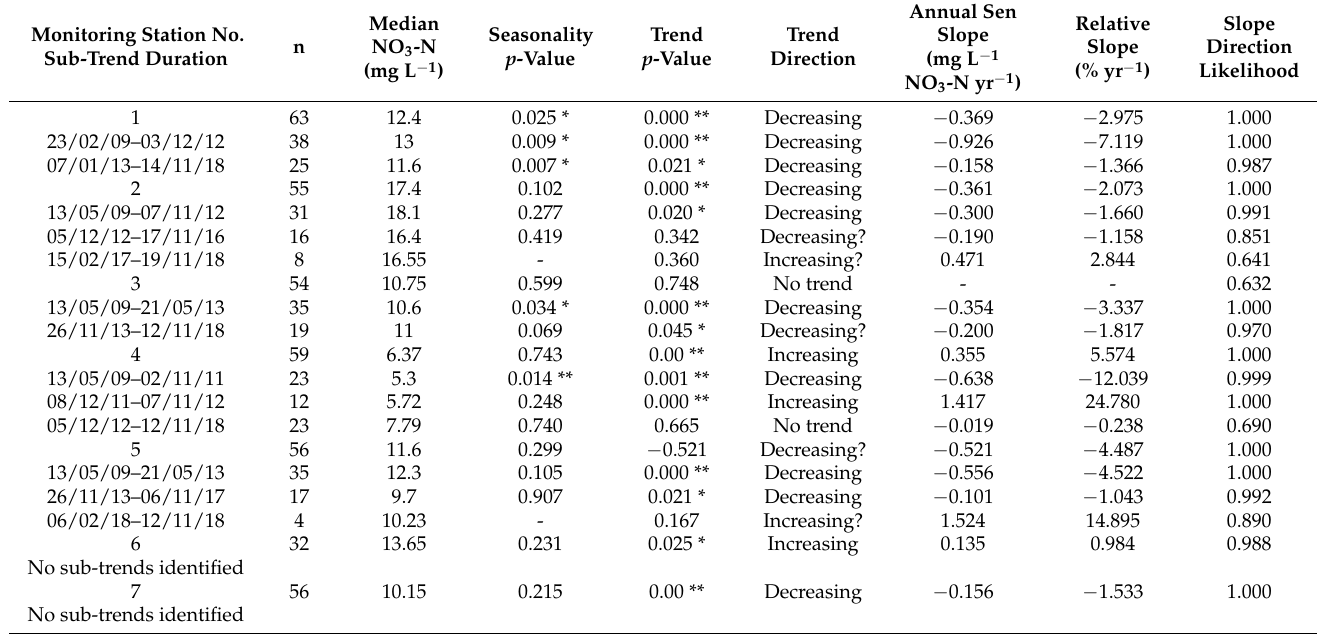
Table 3. Nitrate trend analysis results for the SEPA Ythan groundwater quality monitoring stations 1–7